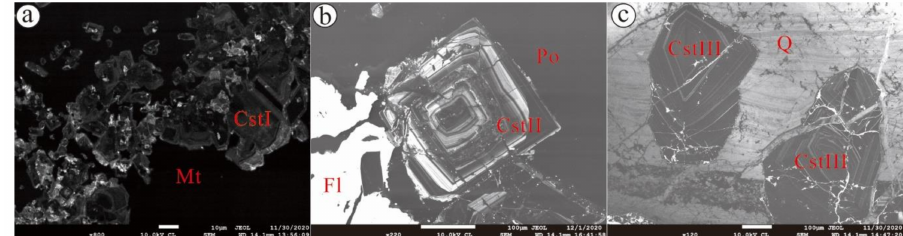
Figure 4. Cathodoluminescence images of three types of cassiterite in the Dulong district. ( a ) Cst I. ( b ) Cst II. ( c ) Cst III. Abbreviations: Cst = cassiterite, Mt = magnetite, Po = pyrrhotite, Fl = fluorite, Q =